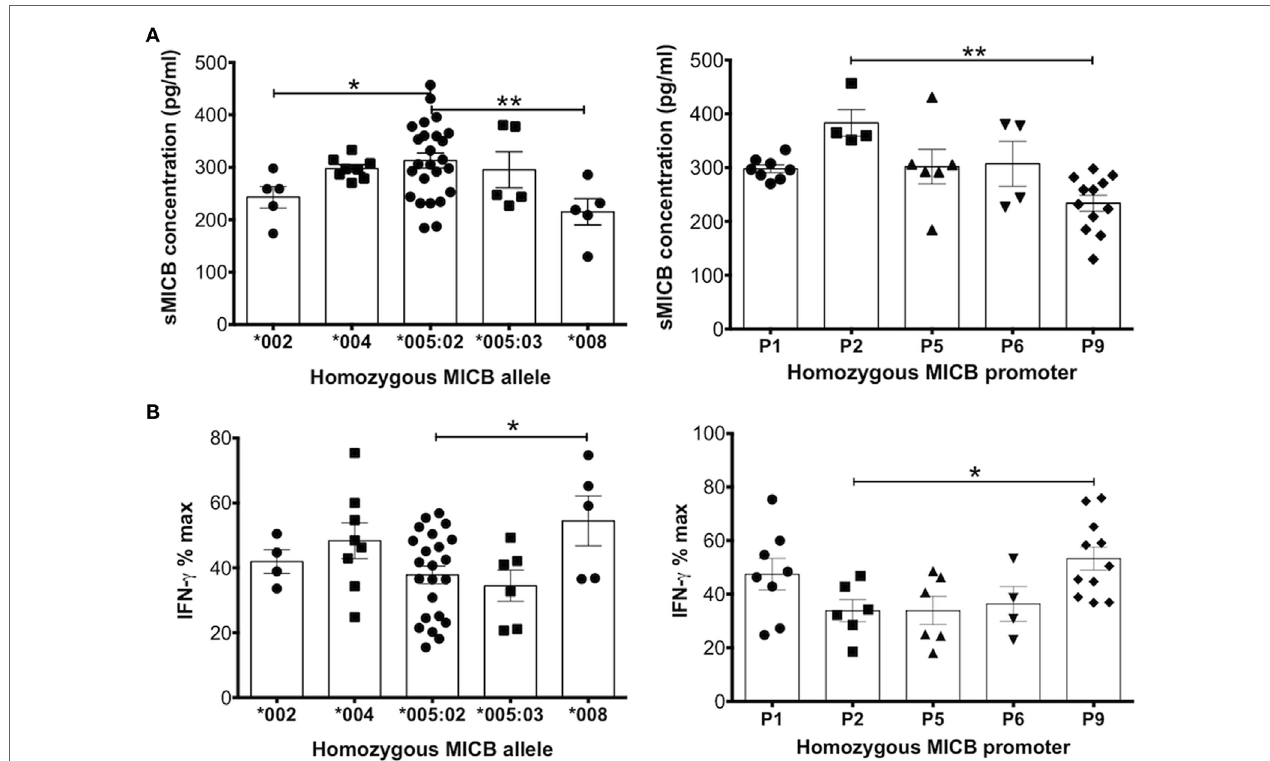
FigUre 4 | MHC class I-related chain B (MICB) allelic and promoter polymorphisms result in differential levels of soluble MICB found in cord blood plasma that influences the potential of these ligands to reduce IFN- γ production after peripheral blood mononuclear cell (PBMC) stimulation. (a) Levels of soluble MICB are significantly different depending on the MICB allele or the MICB proximal promoter type detected in cord blood DNA. (B) Similarly, polymorphic allelic differences or the proximal promoter type of MICB associate with higher or lower levels of IFN- γ . For both types of polymorphism, higher soluble MICB associates with lower IFN- γ . Data represent homozygous MICB typing obtained from a total of 181 cord blood DNA samples. Each experiment was repeated with four different PBMC donors and data points represent donor means Statistical analysis was performed using Kruskal–Wallis test with Dunn’s post hoc test ± SEM (* P ≤ 0.05 and ** P <